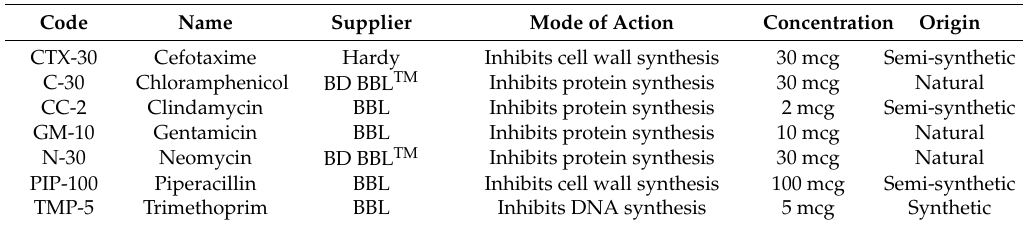
Table 2. Antibiotics used to test for antibiotic resistance, along with code, supplier, mode of action, concentration, and